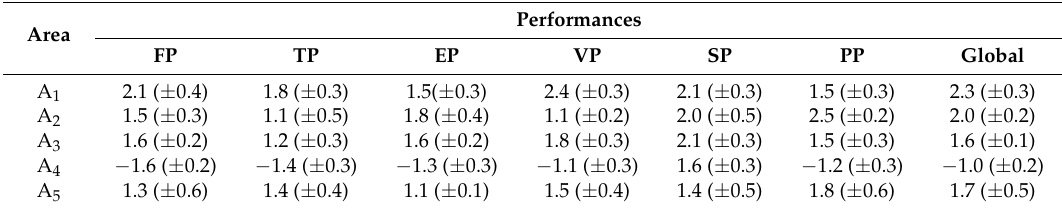
Table 2. Average of the values of the judgements on the performances per Functional Area.